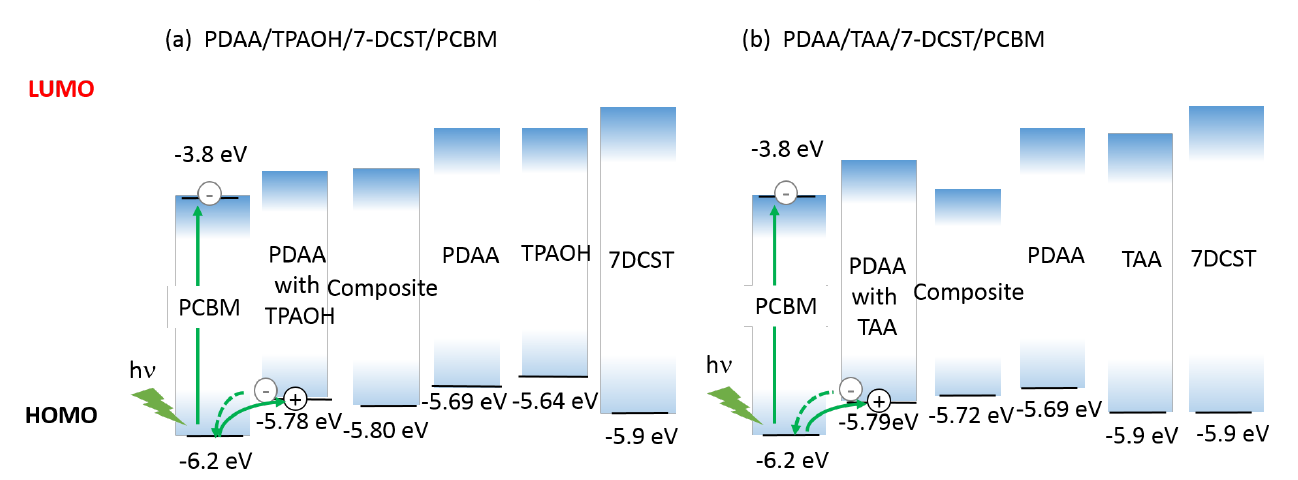
Figure 4. Energy diagram (HOMO and LUMO level) for ( a ) PDAA/TPAOH/7-DCST/PCBM and ( b ) PDAA/TAA/7-DCST/PCBM.